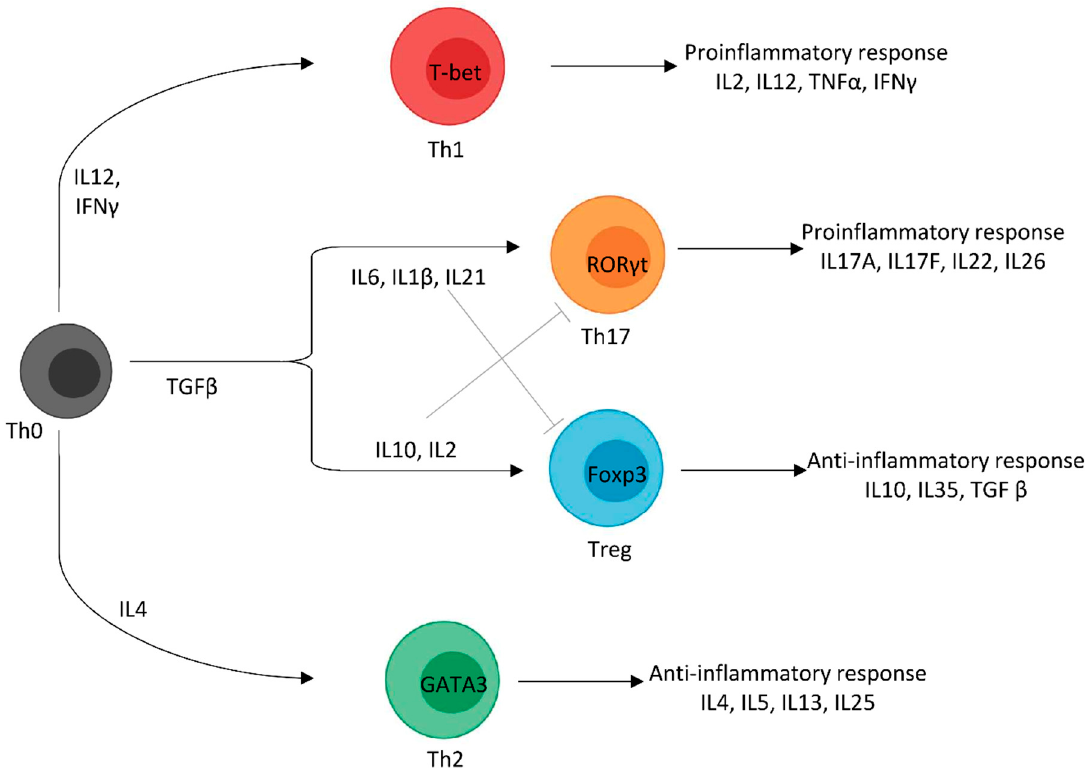
Figure 3. Lymphocyte Th17/Treg balance. CD4+ T cells differentiate in Th1, Th2, Th17, or iTreg (induced regulatory T cells) depending on external stimuli. Th1 cells may aggravate brain injury by secreting pro-inflammatory cytokines (through T-bet), while Th2 cells may have neuroprotective effects on the injured brain by secreting anti-inflammatory cytokines (through GATA-3). The differentiation of Th17 cells from naïve T cells requires TGF- β and IL-6, which induce ROR γ t expression. Th17 cell is characterized by pro-inflammatory cytokines secretion, such as IL17A. In contrast, Foxp3, the master regulator of Tregs is induced by TGF- β and IL-2, and Treg secretes anti-inflammatory cytokines such as TGF- β and IL-10. Th17 and iTregs reciprocally inhibit their differentiation. Created with BioRender.com.